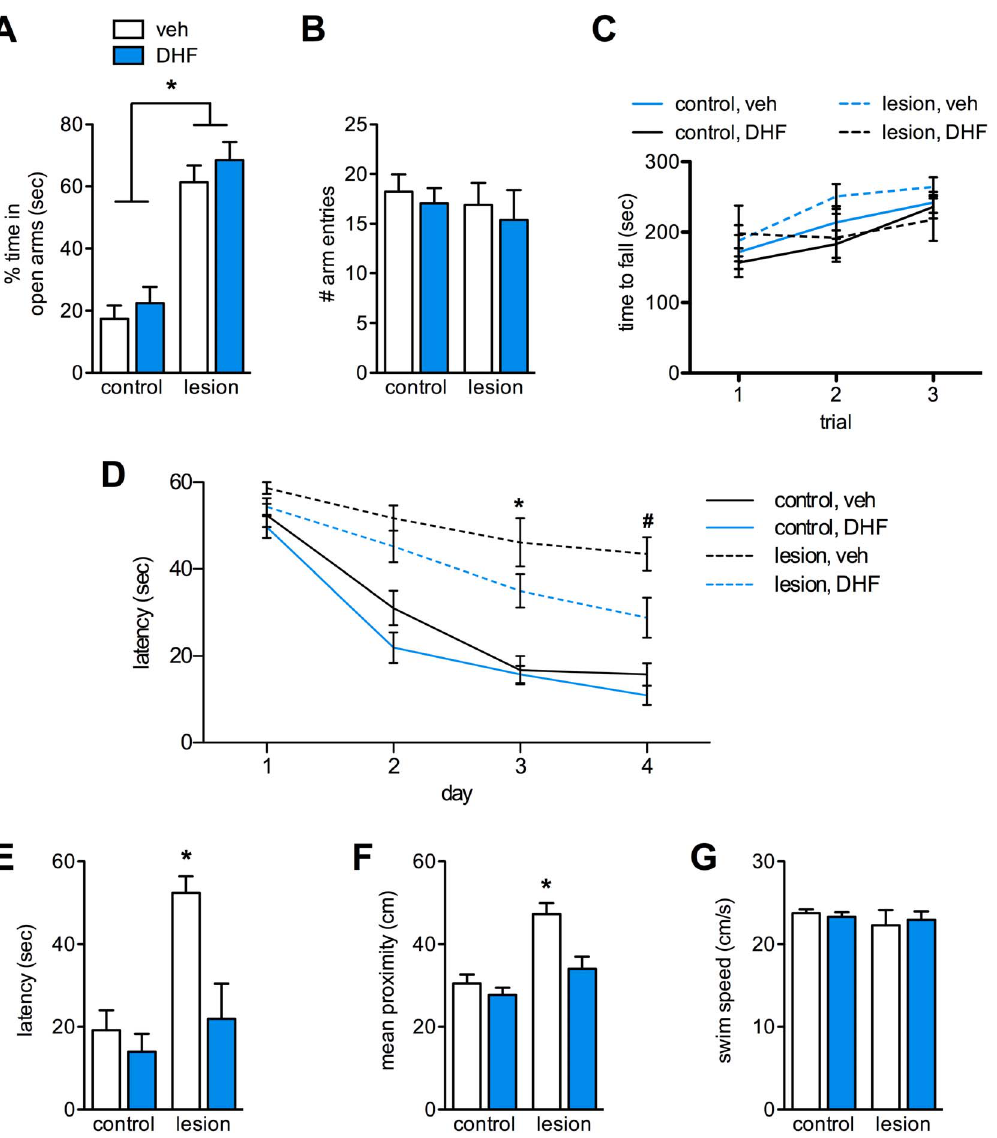
Figure 2. 7,8-DHF treatment improves spatial learning and memory in CaM/Tet-DT A mice. Lesioned CaM/Tet-DT A mice exhibit a significantly increased preference for the open arms of an elevated plus maze compared to controls ( A , n =9–12, p , 0.0001). All groups made a similar total number of arm entries ( B ). 7,8-DHF treatment did not alter preference for open or closed arms ( A–B ). A rotarod test reveals no differences between groups in the time to fall off an accelerating rod ( C ). During water maze training, lesioned mice treated with 7,8-DHF were not significantly slower to reach the escape platform compared to controls, except for day 3 ( D , n =9–12, p , 0.001). On day 4, lesioned mice treated with 7,8-DHF reached the platform significantly faster than lesioned mice that received vehicle ( D , n =9–12, # , p , 0.05). On the 24 hr probe trial, latencies to reach and mean proximity to the former platform location were not significantly different between 7,8-DHF-treated lesioned mice and controls ( E– F , n =9–12, p . 0.05). All groups had a similar average swim speed during the probe trial ( G